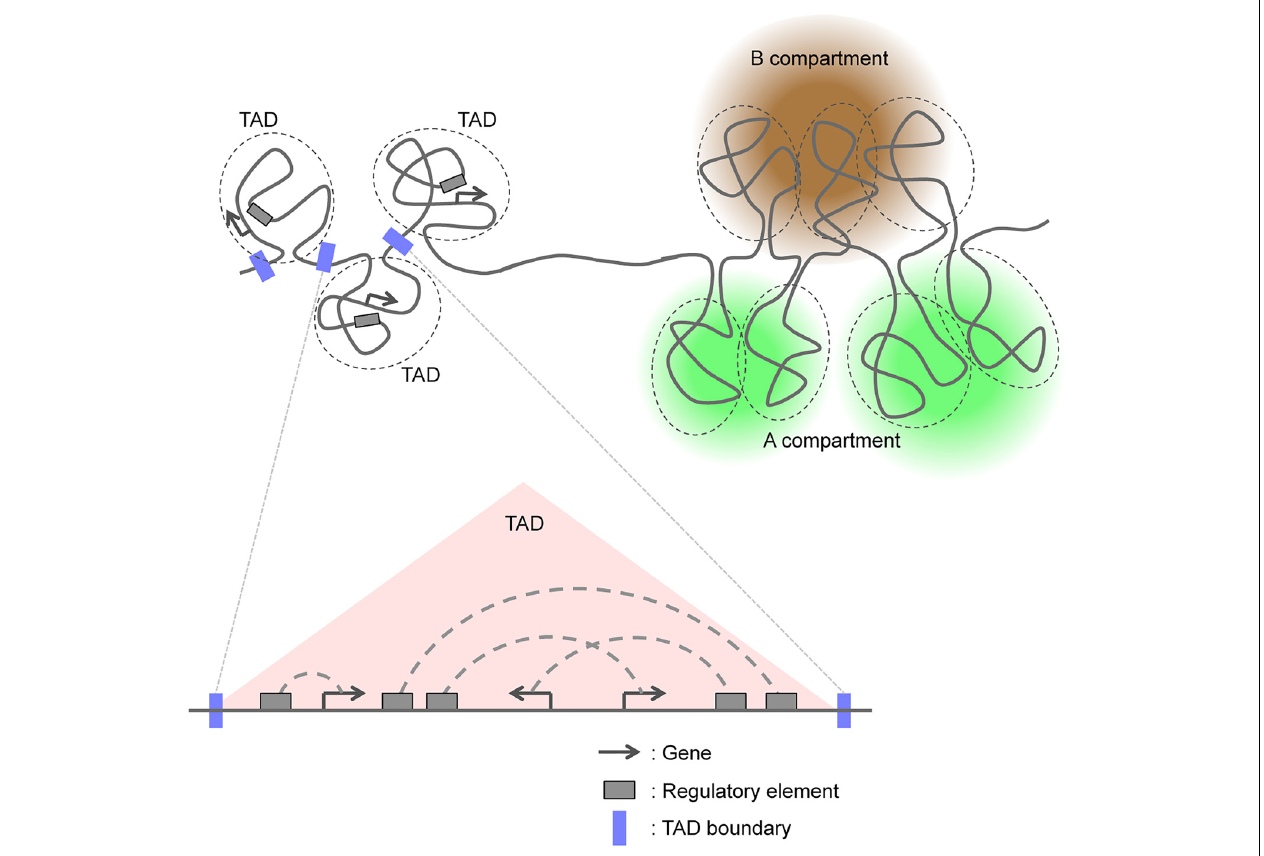
FIGURE 1 | Three-dimensional genome organization based on TADs and A/B